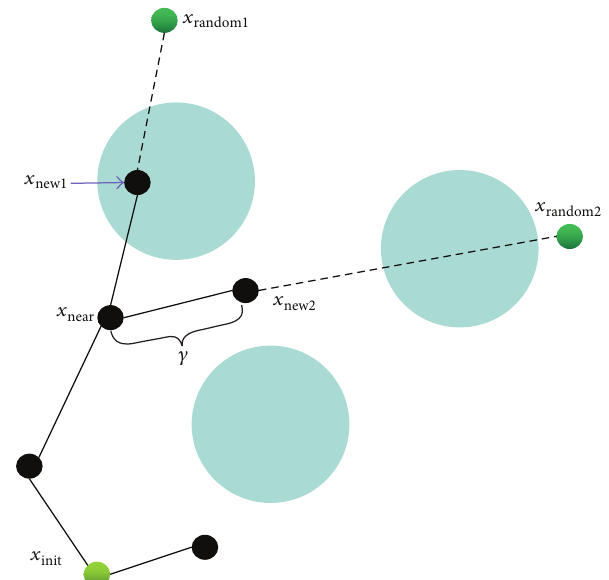
Figure 7: Exploring procedure of RRT algorithms. The cyan circles representobstacleregionswhichcannotbepassed. 𝛾 ismaximalstep extending length according to constraints and cost function stated.